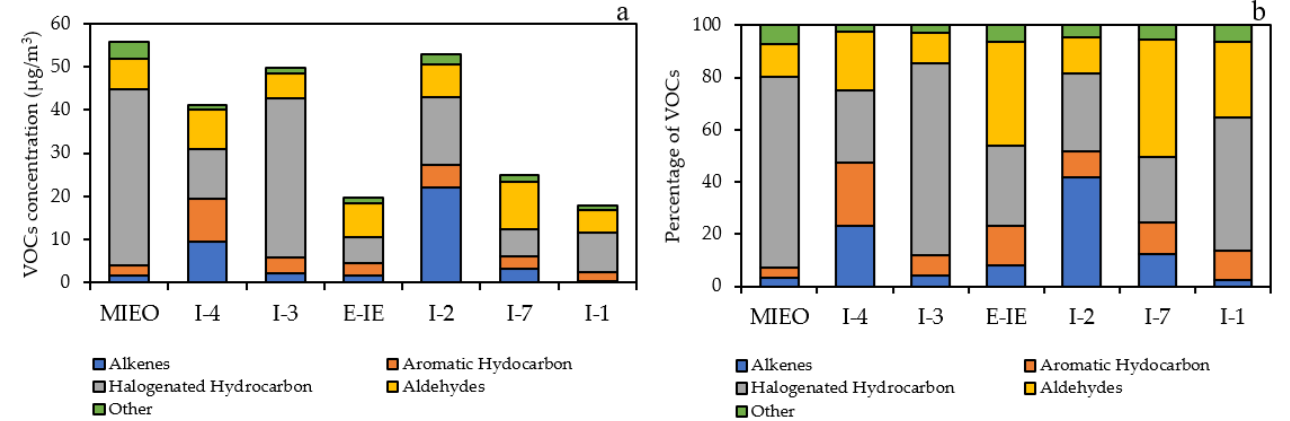
Figure 3. Concentration ( a ) and contribution ( b ) of five VOCs categories within the industrial ar- eas.